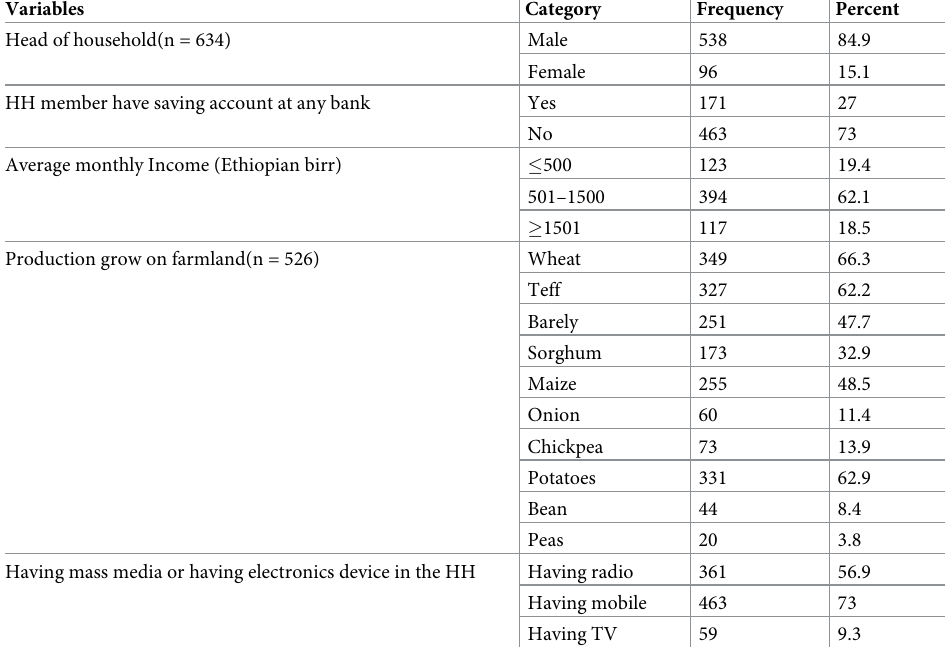
Table 2. Socio-economic characteristics in Jeldu district West Shoa zone, Oromia, Ethiopia, March 25 –April 15, 2018. Variables